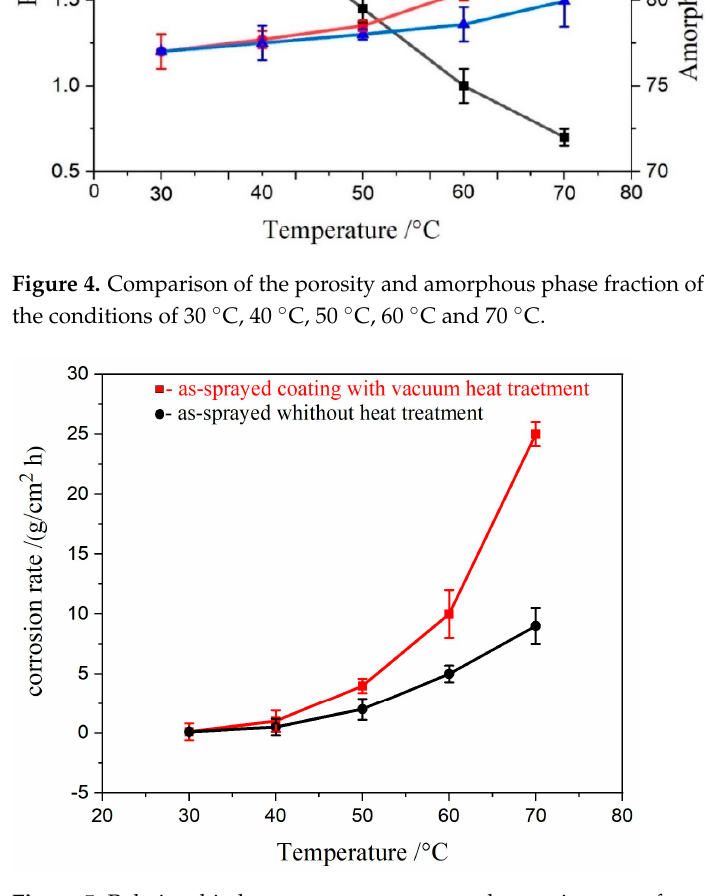
Figure 4. Comparison of the porosity and amorphous phase fraction of the coatings deposited under the conditions of 30 °C, 40 °C, 50 °C, 60 °C and 70 °C.